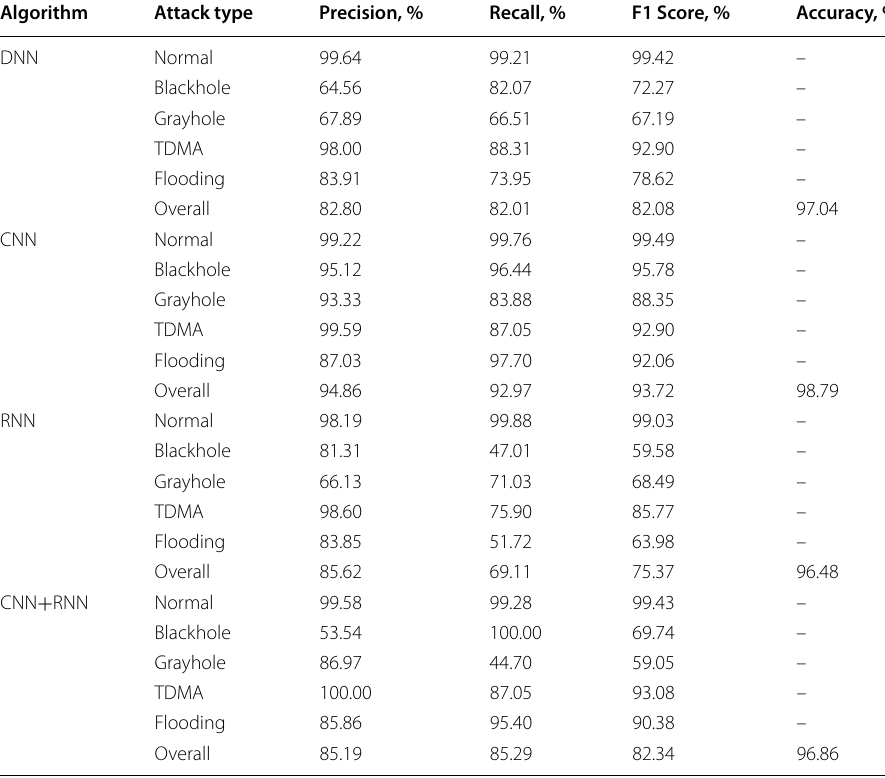
Table 9 Performance of each algorithm on testing data